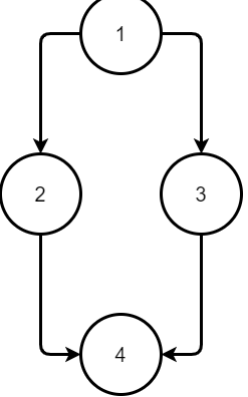
Figure 10. State-space graph